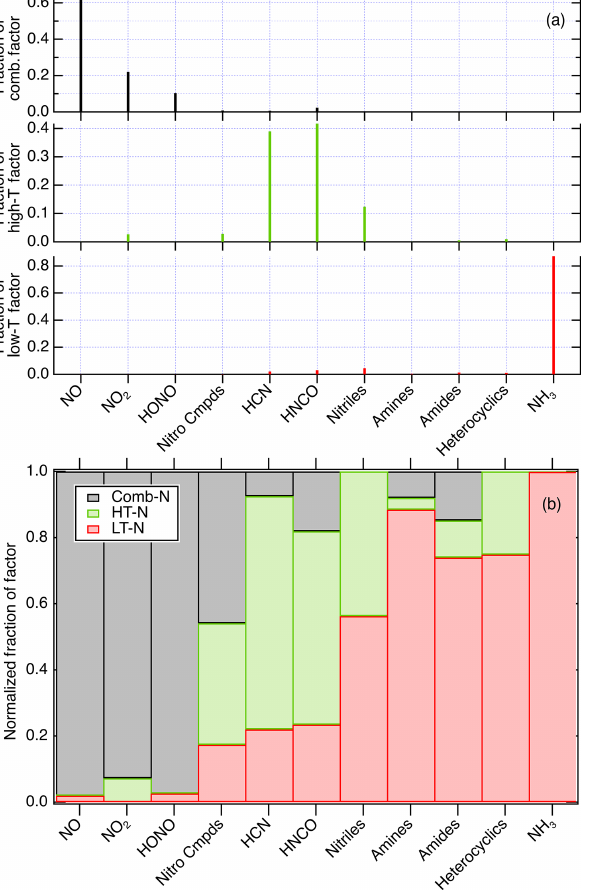
Figure 9. (a) The contributions of nitrogen species to the factors that simulate the emissions from coniferous fuels shown in Fig. S2 and (b) the fraction of each compound or class found in each